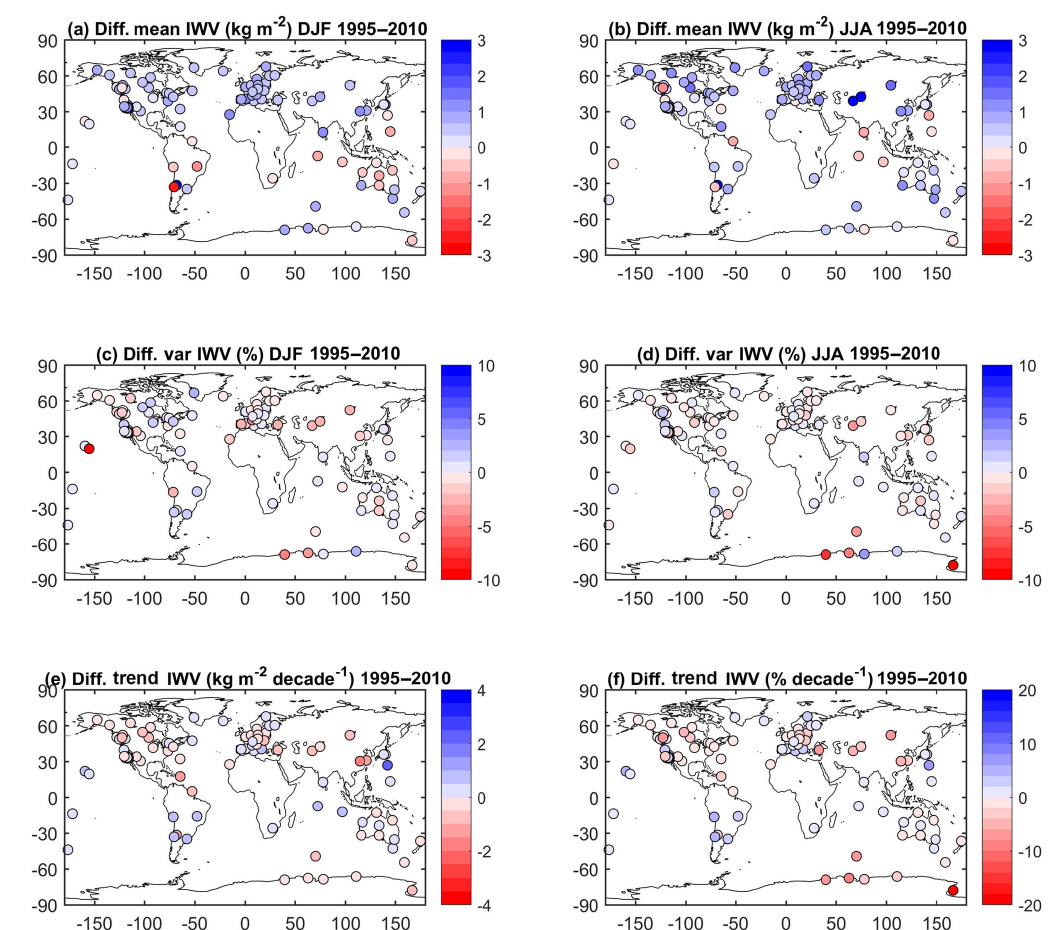
Figure B1. (a) Difference of mean IWV estimates (ERA-Interim minus GPS) for DJF 1995–2010 from time-matched IWV series, (b) same as panel (a) for JJA, (c) difference of relative variability estimates (ERA-Interim variability minus GPS variability) for DJF 1995–2010 from time-matched IWV series, (d) same as panel (c) for JJA, (e) difference of trend estimates (ERA-Interim minus GPS) for 1995–2010 from time-matched IWV series, (f) same as panel (e) for relative